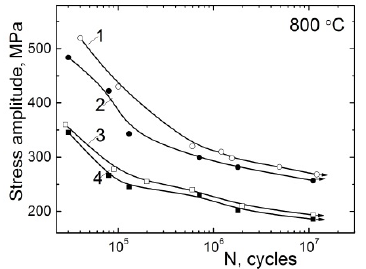
Figure 7. Endurance curves of the CM88Y (1, 2) and ZhS3DK (3, 4) in air (1, 3) and hydrogen at a pressure of 30 MPa (2, 4).